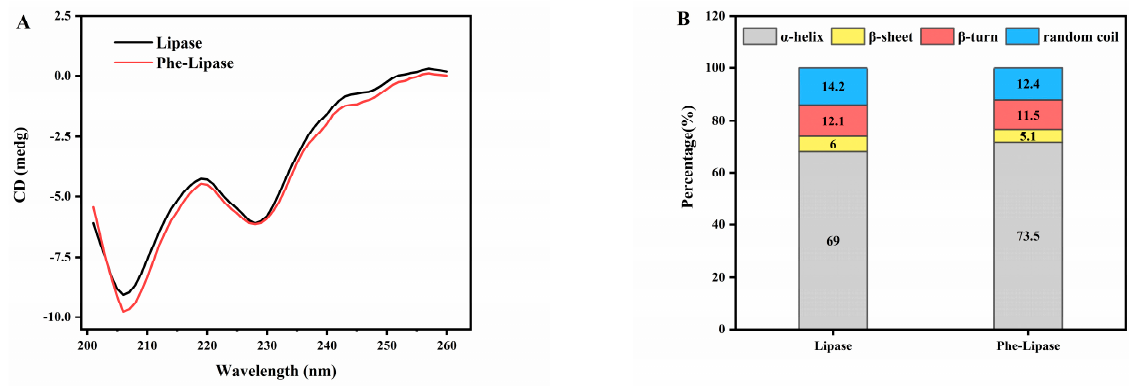
Figure 6. ( A ) Circular dichroism spectra (CD) and ( B ) secondary structure fractions of pancreatic lipase within the absence/presence of pheophytin (Phe). Data were shown as mean ± SD of three replicates.